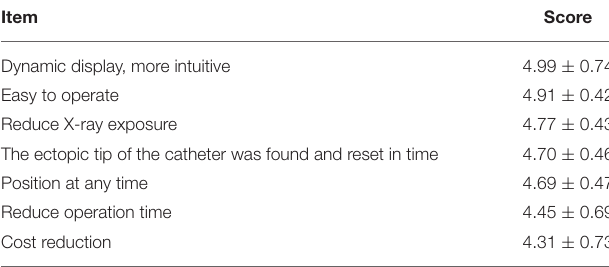
TABLE 3 | Advantage score of neonatal ultrasound localization (score, ¯ x ± s).